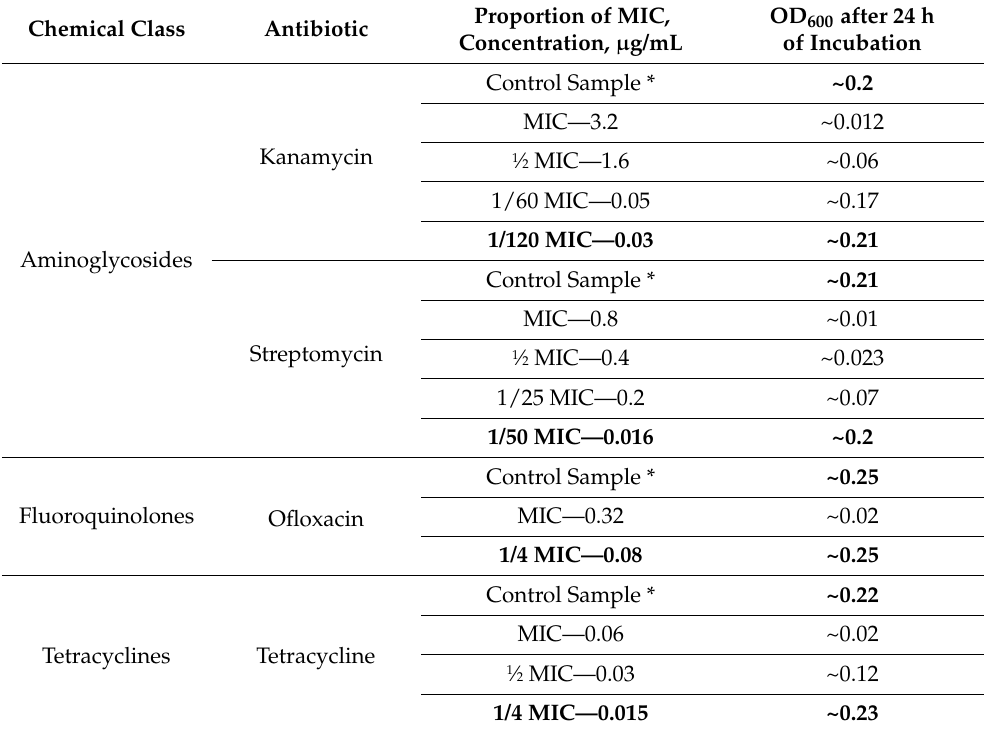
Table 2. The determination of target concentrations of antibiotics, which do not inhibit growth of M. smegmatis . The OD 600 at 0 h of incubation (start point) was 0.01 for all antibiotics. The experiment was repeated in three independent biological replicates—the table shows the average values of optical density. The concentration at which the optical density in the control and experimental groups was the same after 24 h was considered to be the maximum non-inhibiting concentration, * M. smegmatis mc2 155 without